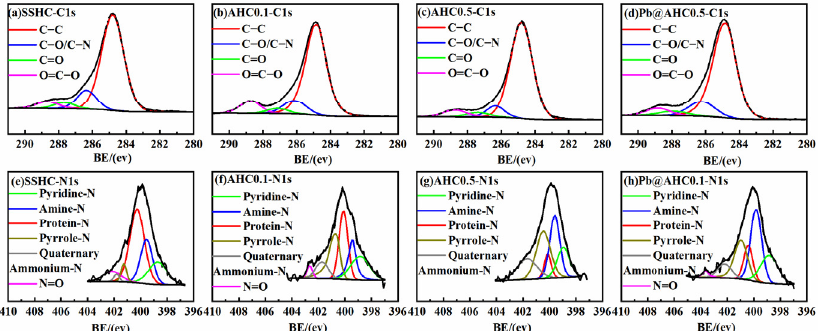
Figure 2. C1s and N1s XPS spectra of SS-derived hydrochars and Pb@AHC0.1. Table 3. Deconvolution results of C1s and N1s